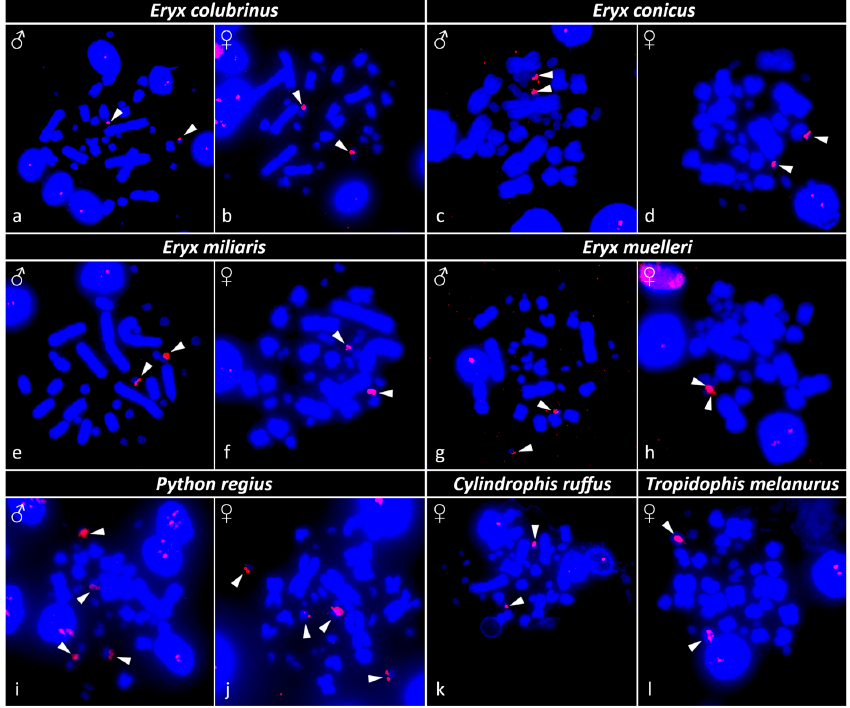
Figure 4. The distribution of rDNA loci in metaphases for the species: ( a , b ) Eryx colubrinus , ( c , d ) Eryx conicus , ( e , f ) Eryx miliaris , ( g , h ) Eryx muelleri , ( i , j ) Python regius , ( k ) Cylindrophis ruffus , and ( l ) Tropidophis melanurus , marked with arrowheads. Sex is indicated.